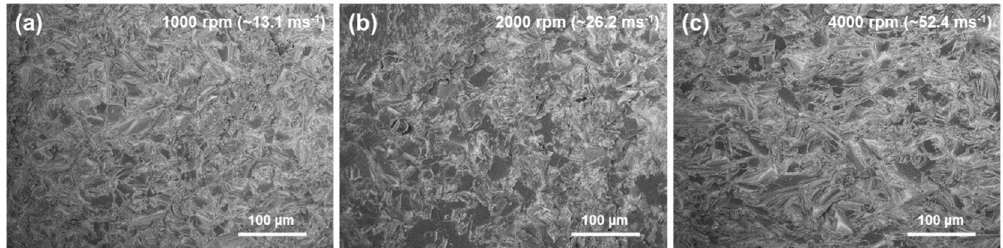
Figure 4. SEM images of fractured surfaces of the bulks of Bi 0.36 Sb 1.64 Te 3 fabricated from melt-spun ribbons at ( a ) 1000 (BST1000), ( b ) 2000 (BST2000), and ( c ) 4000 (BST4000) rpm wheel rotation speed during the MS process.